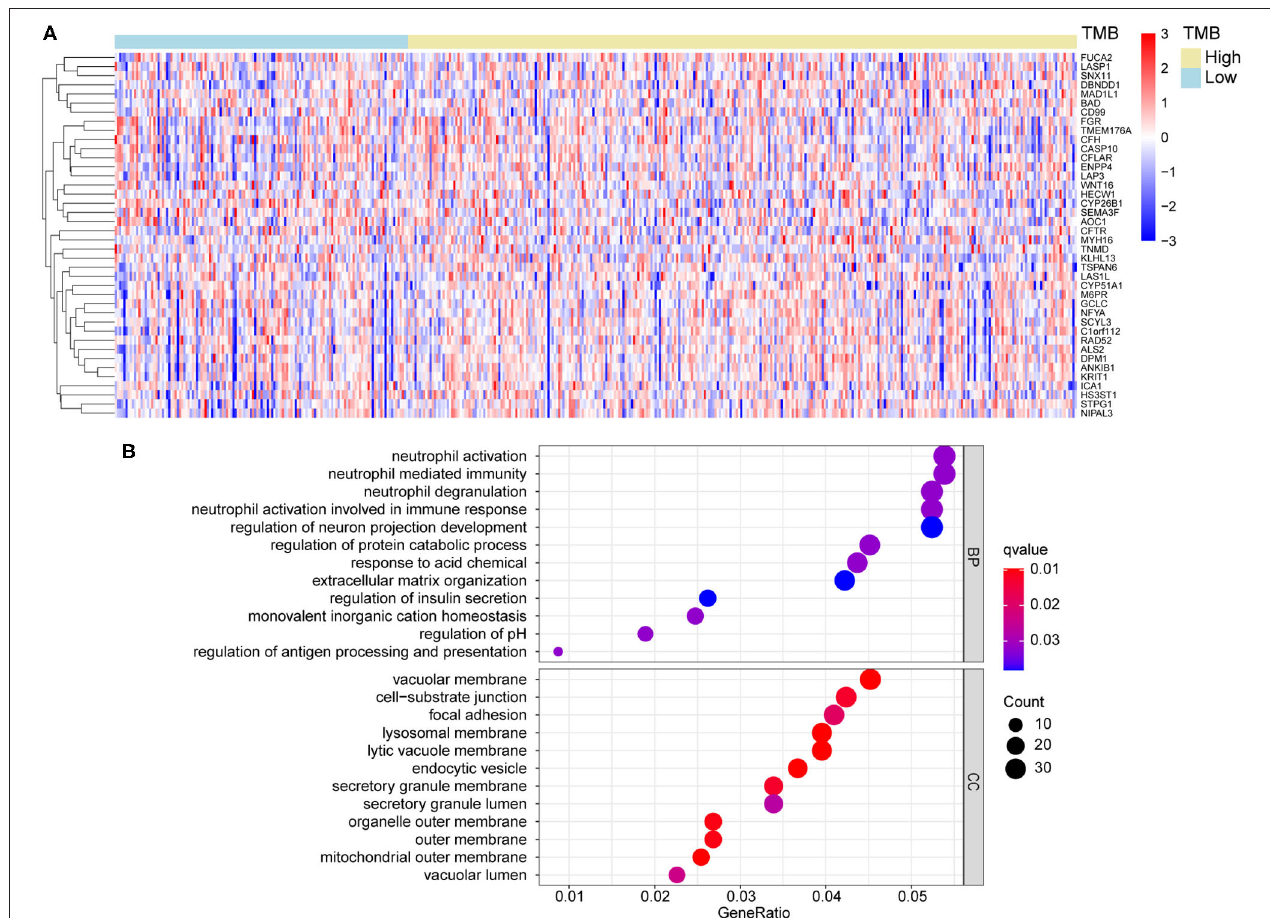
FIGURE 3 | Differential gene analysis and GO analysis. (A) Heatmap of top 40 DEGs between high- and low-TMB groups. (B) DEGs were mainly enriched in immune related and cell adhesion related pathways. DEGs, differentially expression genes. BP, biological process; CC, cellular component.